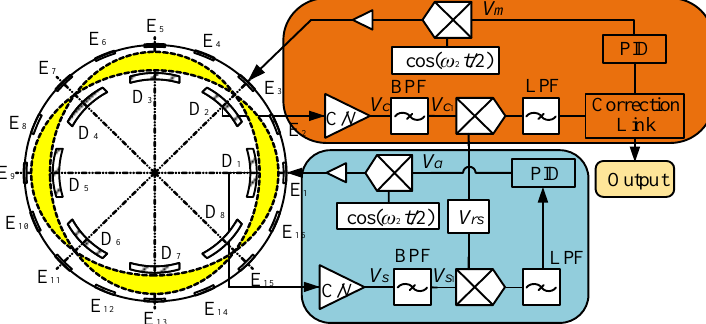
Figure 5. The structure diagram of the feedback control system for HRG with single-electrode mode.